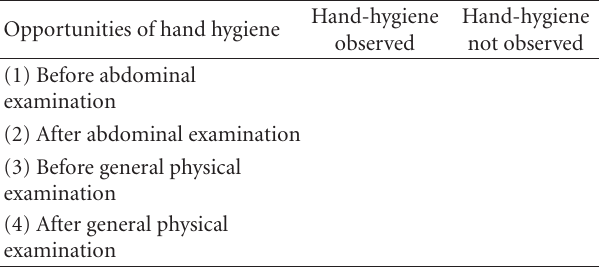
Table 1: Self-designed questionnaire used for assessment of hand hygiene awareness.